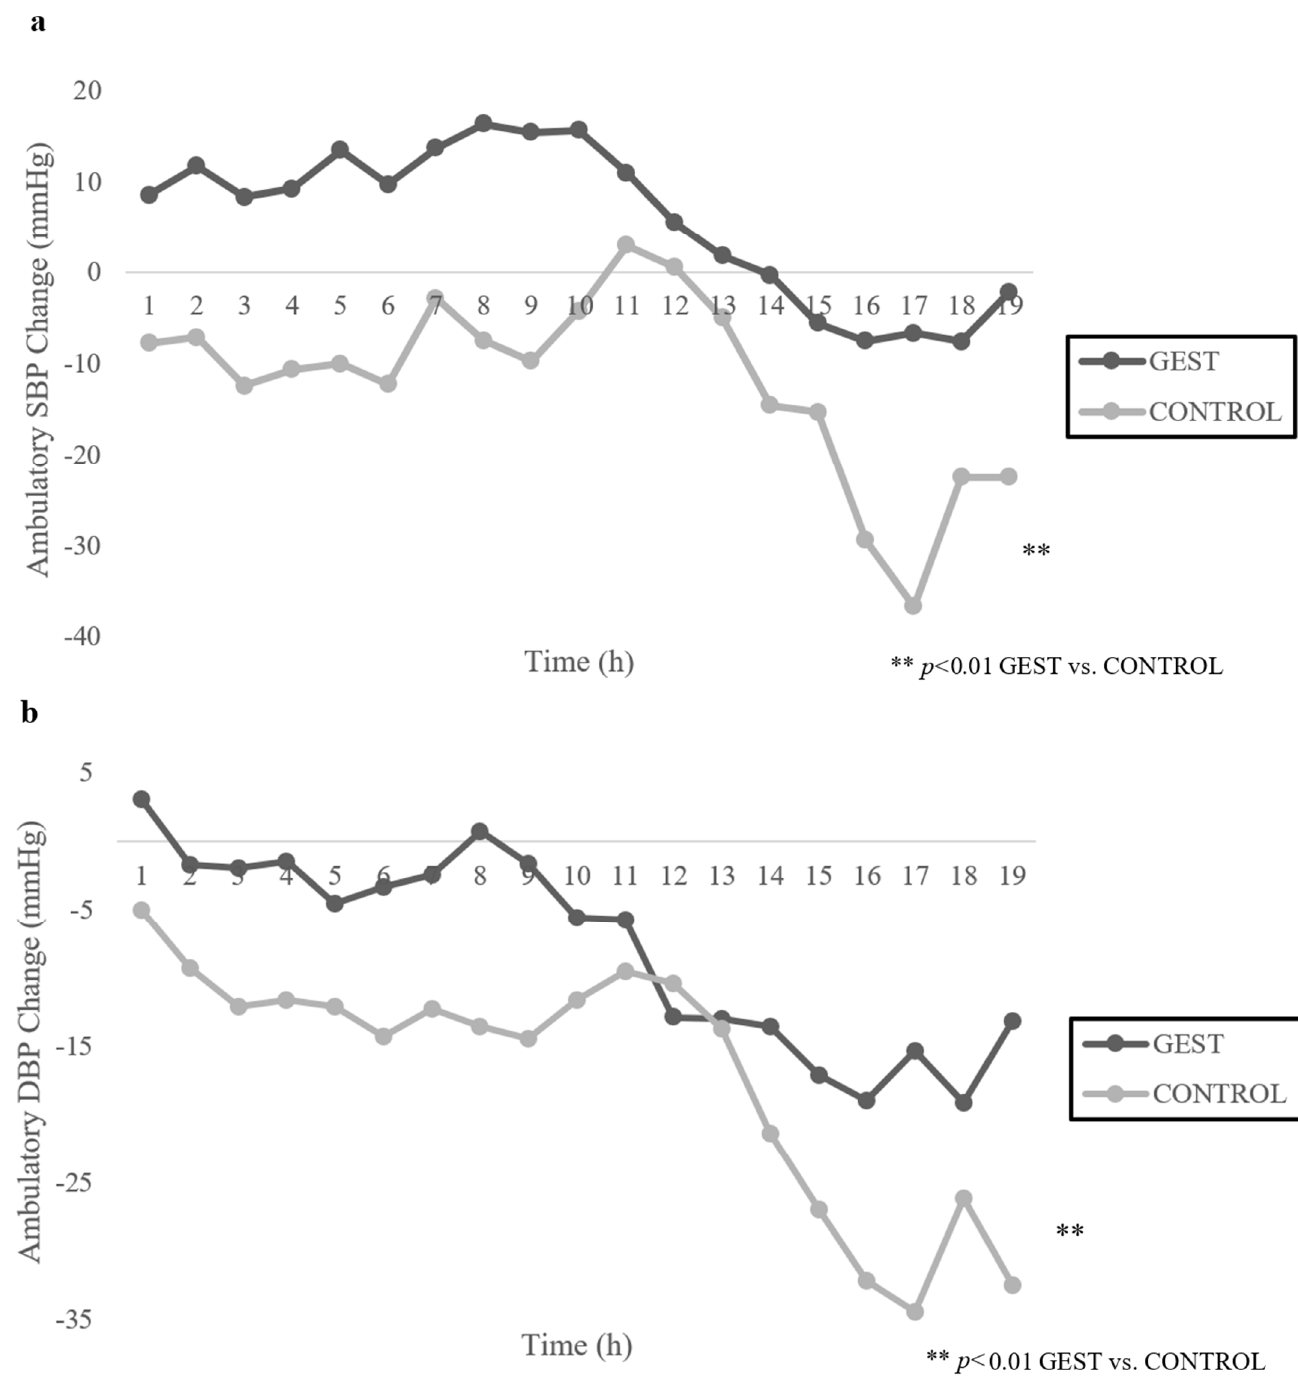
Figure 2. ( a , b ): Mean Change in Ambulatory Blood Pressure from Baseline Following GEST vs.